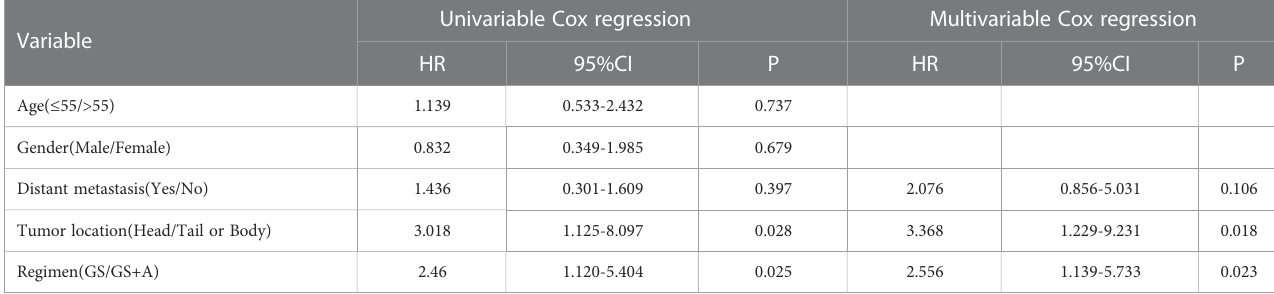
TABLE 5 Univariate and Multivariate analysis of OS.